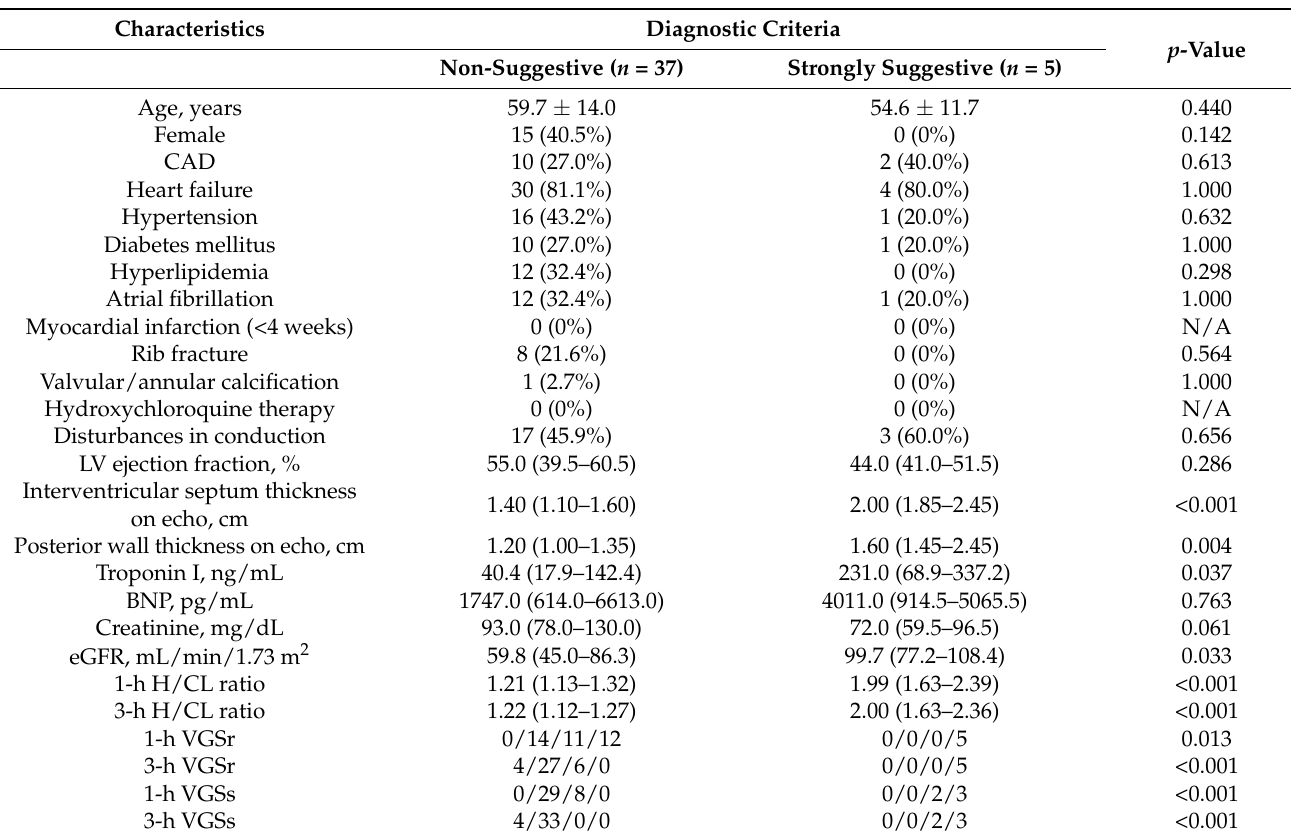
Table 1. Demographic and clinical characteristics of patients referred for 99m Tc-PYP scintigraphy.